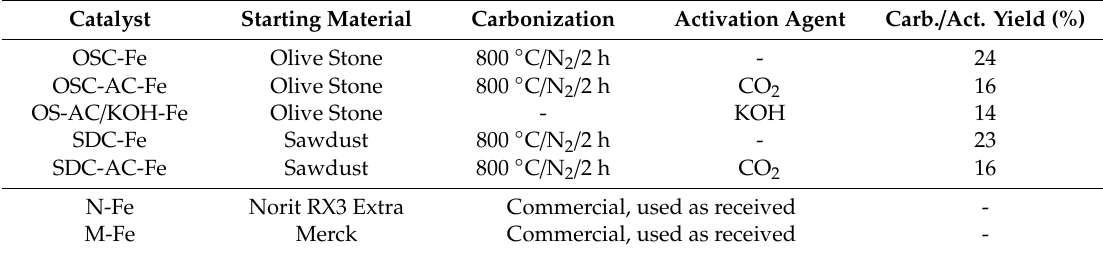
Table 1. Summary of synthesis conditions, nomenclature of catalysts and yield values of the carbonization / activation